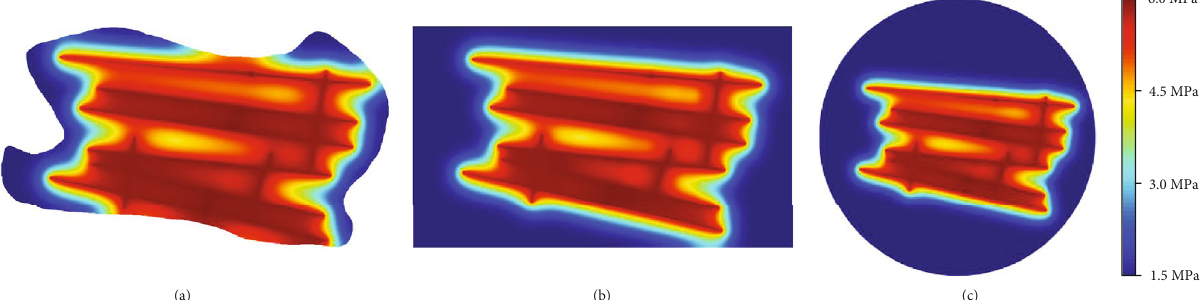
Figure 7: Pressure distribution after 720 days of injection in di ff erent boundary shapes: (a) irregular boundary shape, (b) rectangular boundary shape, and (c) circular boundary.